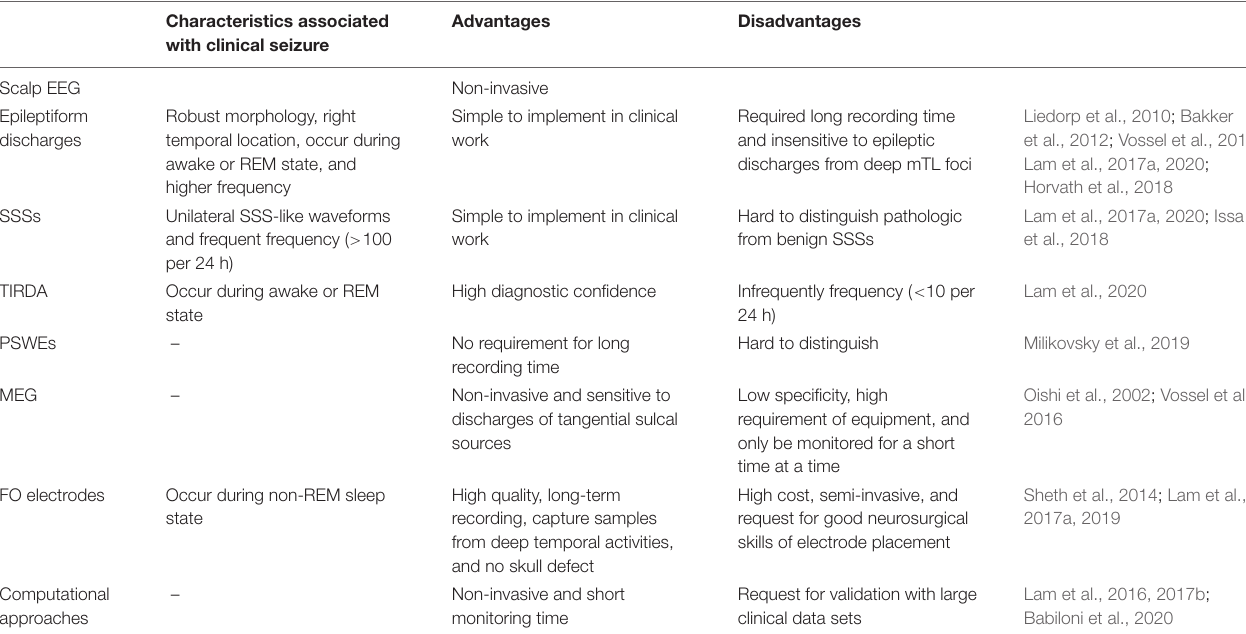
TABLE 1 | Electrophysiological biomarkers of AD-related increase of cortical